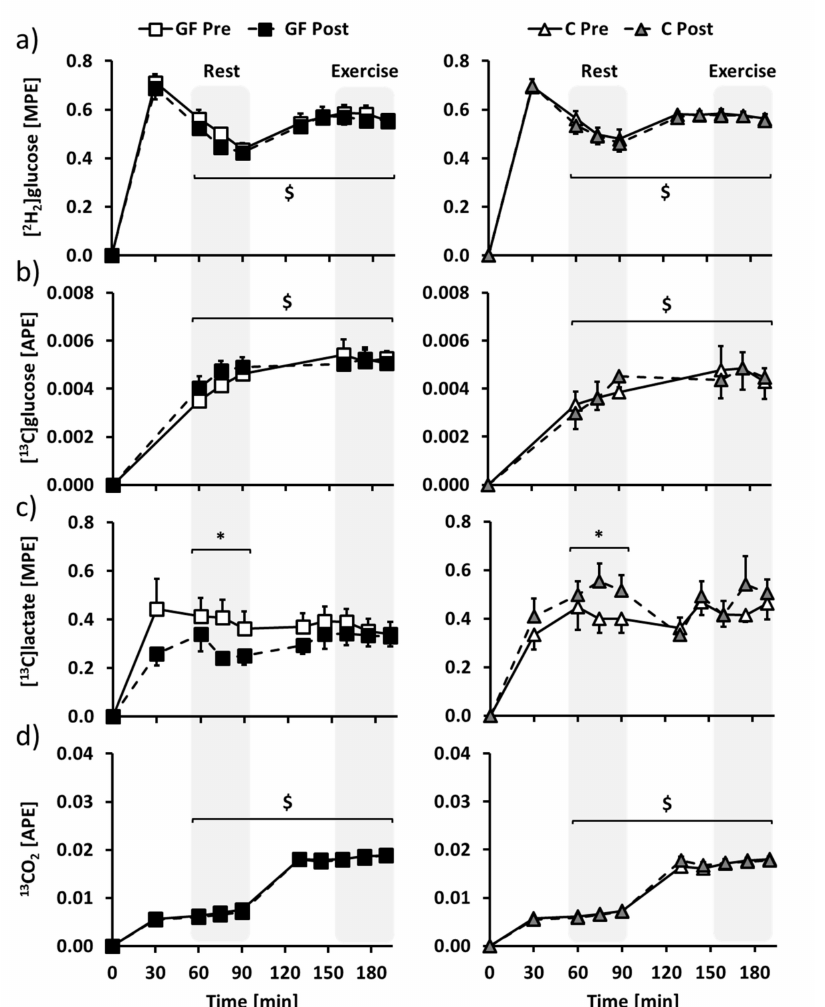
Figure 4. Changes over time of plasma ( a ) ( 2 H 2 )glucose, ( b ) ( 13 C)glucose, ( c ) ( 13 C 1 )lactate and ( d ) expired air 13 CO 2 isotopic enrichments in GF ( left ) and C ( right ) participants during metabolic evaluations. Glucose-fructose drinks were provided in all tests, both during rest (time = 0–90 min) and exercise (time = 100–190 min) periods. GF pre-training (GF Pre) and C pre-training (C Pre) is indicated in white, GF post-training (GF Post) in black and C post-training (C Post) in grey. Effects of exercise and training interventions were compared using a mixed-model analysis. Paired contrasts were used for rest vs. exercise periods (E effect: $: p < 0.01) and training × interventions (T × I effect: *: p < 0.05). Dashed zones: Measures considered for tracer calculations. Mean ± SEM for n = 8 participants in all